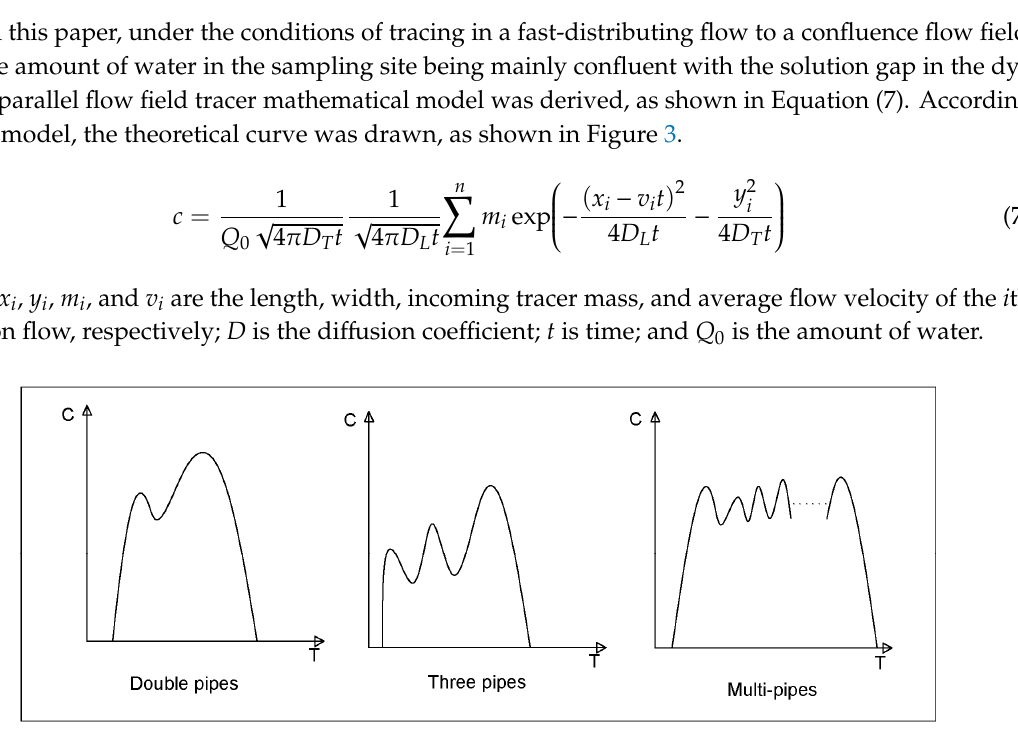
Figure 2. Schematic of the pipe-fissure.